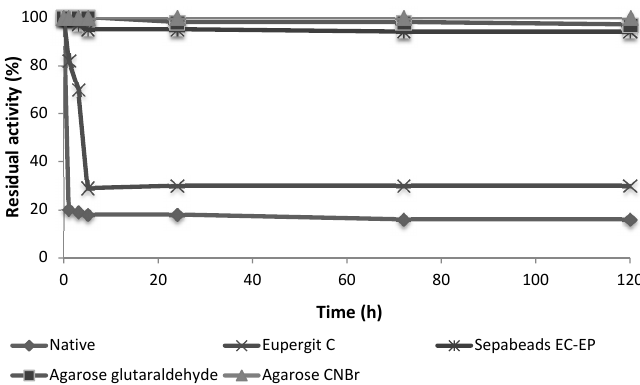
Figure 2. Stability of protease N derivatives in 30% v / v of acetonitrile. Experimental conditions: 30% CH 3 CN in 25 mM phosphate buffer pH 7, immobilized protease N 250 mg, volume 1 mL, r.t.